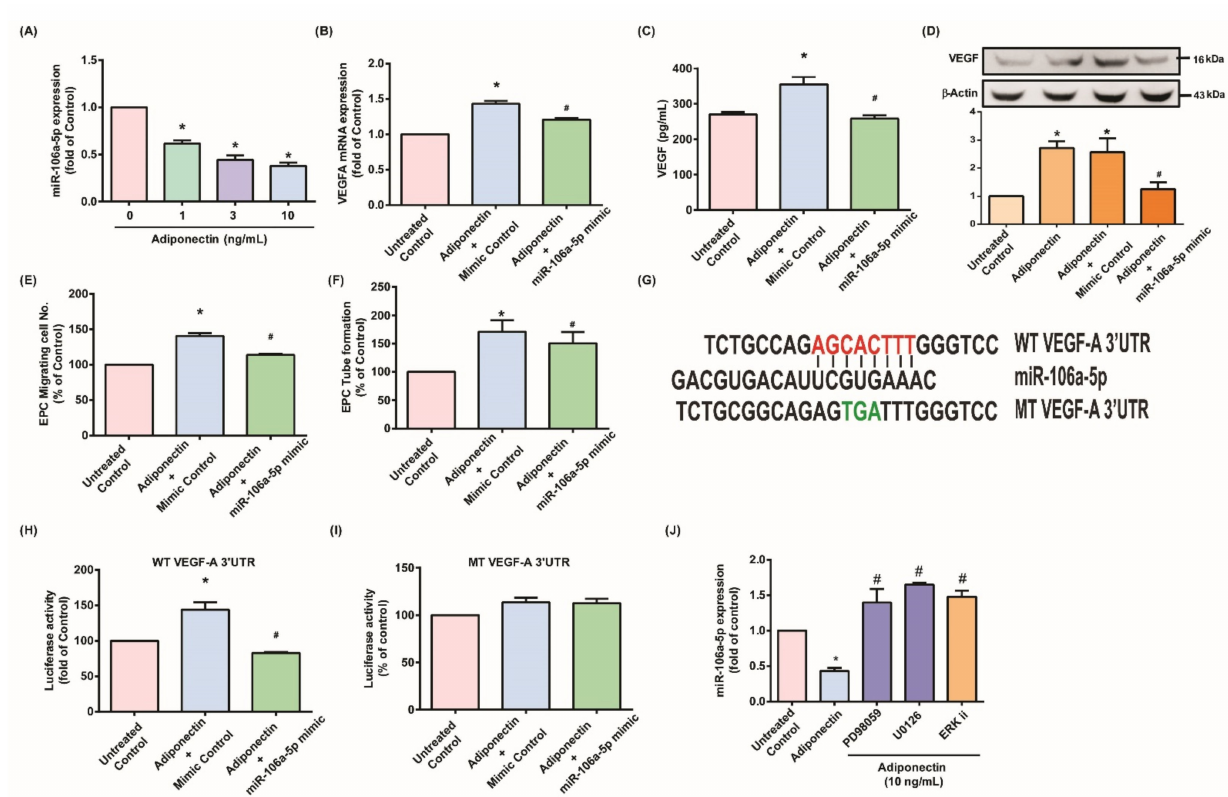
Figure 5. Adiponectin enhances VEGF-dependent angiogenesis via the suppression of miR-106a-5p. ( A ) MH7A cells were incubated with various concentrations adiponectin for 24 h. miR-106a-5p expression was determined by the qPCR assay. ( B – D ) MH7A cells were transfected with mimic control or miR-106a-5p mimic for 24 h, then stimulated with adiponectin for 24 h. VEGF levels were determined by qPCR, ELISA, and Western blot assay ( n = 4). ( E , F ) Collected CM was applied to EPCs and EPC angiogenesis was quantified. ( G ) Schematic 3 (cid:48) UTR representation of human VEGF containing the miR-106a-5p binding site. ( H , I ) MH7A cells were transfected with the indicated luciferase plasmid with or without miR-106a-5p mimic for 24 h, then stimulated with adiponectin for 24 h. Relative luciferase activity was determined. ( J ) MH7A cells were pretreated with MEK or ERK inhibitors for 30 min, then stimulated with adiponectin for 24 h. miR-106a-5p expression was quantified by qPCR. * p < 0.05 versus the control group; # p < 0.05 versus the adiponectin-treated